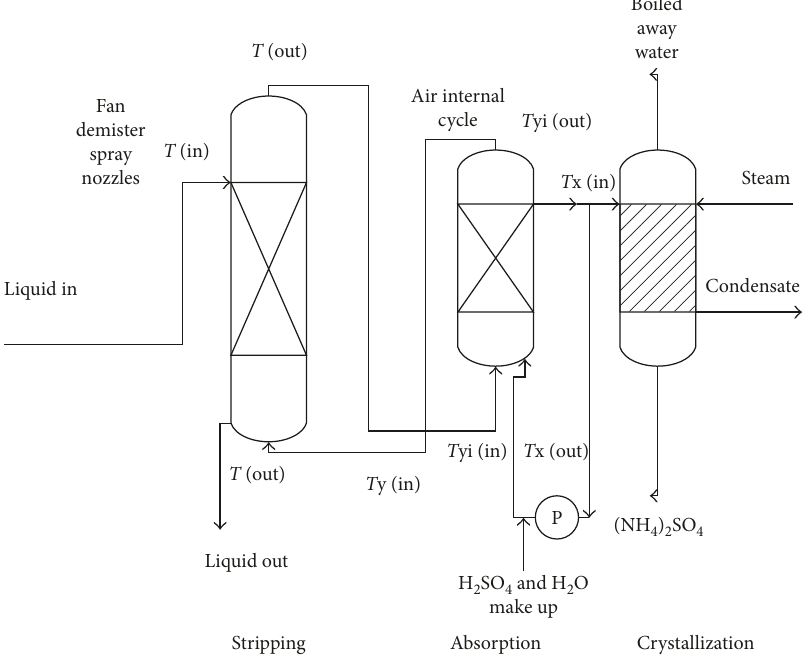
Figure 3: Proposed plant for ammonia stripping for industrial effluent application [12].